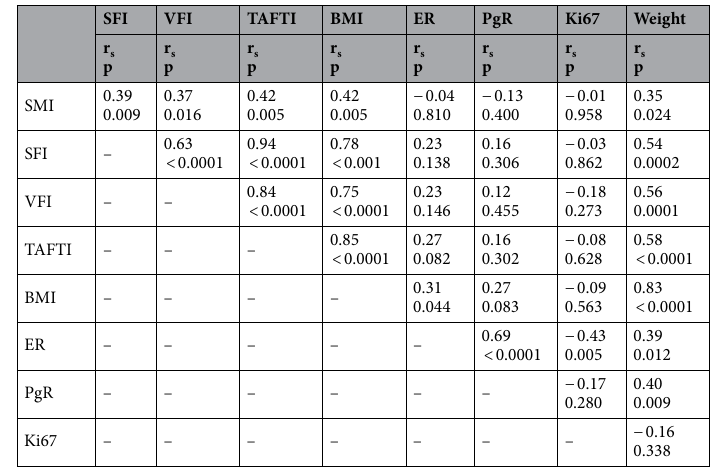
Table 5. Spearman correlation analysis of the body composition parameters. BMI body mass index, SMI skeletal muscle index, SFI subcutaneous fat index, VFI visceral fat index, TAFTI Total abdominal fat index, ER estrogen receptor, PgR progestin